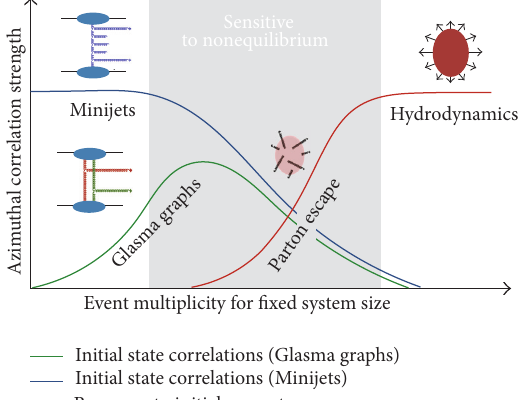
Figure 2: Illustration of long range azimuthal correlations in small systems, a slightly modified version of the figure from